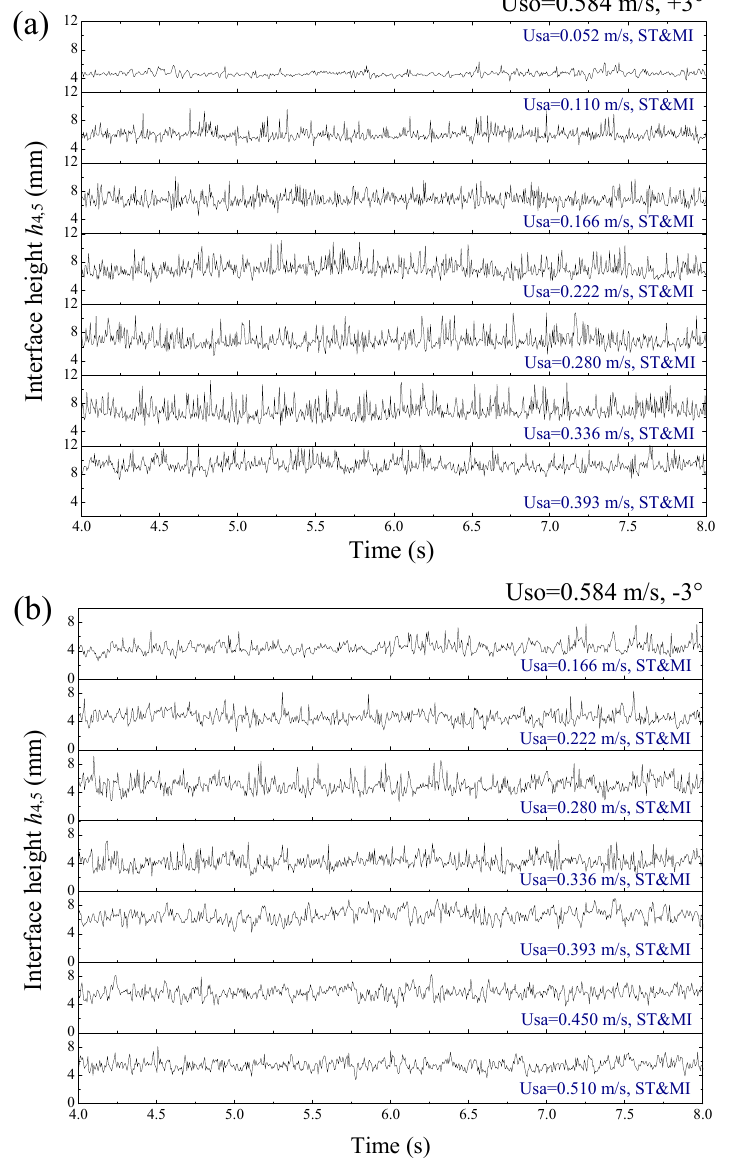
Figure 16. Fluctuating signals from electrode pairs 4 and 5: ( a ) Uso = 0.584 m/s, +3°; ( b ) Uso = 0.584 m/s, − 3°.